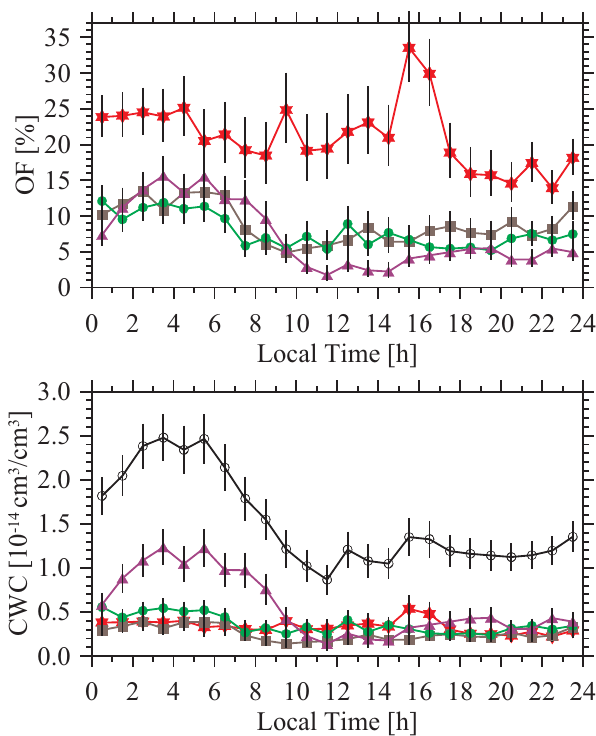
Fig. 9. Diurnal variation of NLC occurrence (top) and cloud wa- ter content CWC (bottom) determined from ALOMAR RMR-lidar measurements for the integrated data set from 1997 to 2010. Data for faint (red stars), weak (brown squares), medium (green filled circles) and strong (purple triangles) clouds are shown. The black curve (open circles) at the lower panel is the integrated CWC over all cloud classes. Vertical bars indicate confidence limits for the occurrence at 95%-level and errors of the means for